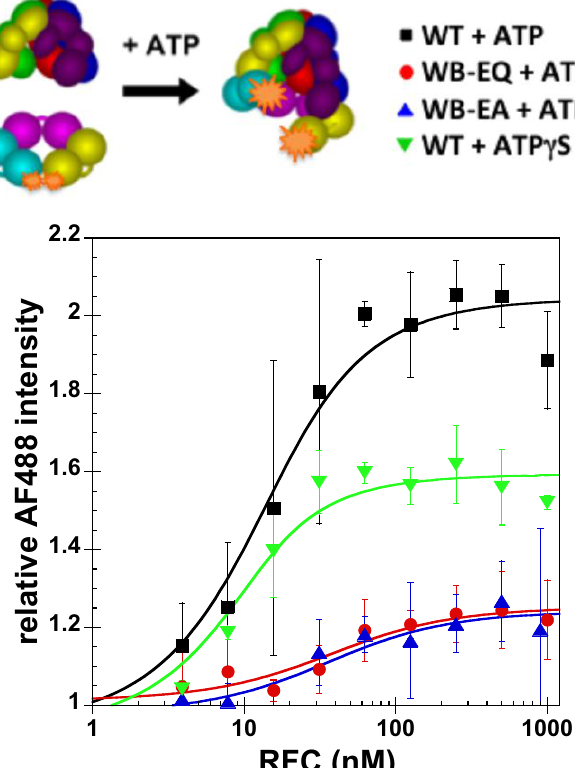
Figure 3. Clamp opening activities of WT RFC and Walker B mutants. Binding of WT RFC to PCNA-AF488 was measured in the presence of ATP (black squares) or ATP (cid:534) S (green inverted triangles), and binding of the WB-EQ mutant (red circles) and WB-EA mutant (blue triangles) to PCNA-AF488 was measured in the presence of ATP. The relative intensity of AF488 at 517 nm is plotted as a function of RFC concentration for solutions containing 10 nM PCNA-AF488 and 0.5 mM ATP or ATP (cid:534) S. Data shown are the average of three independent experiments. Error bars represent standard